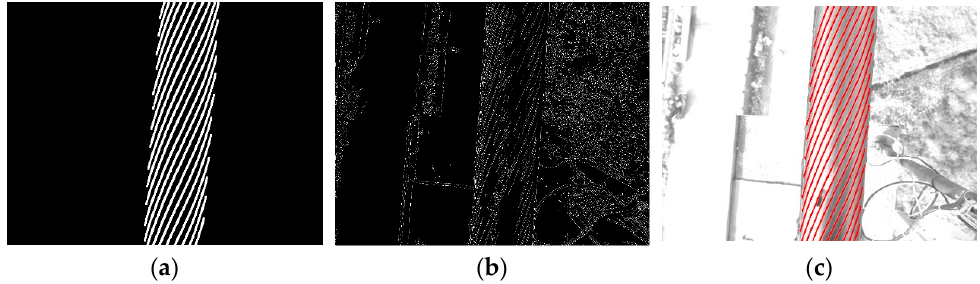
Figure 8. The result of strand segmentation by the proposed method. ( a ) Segmentation template; ( b ) Edge detection result with FoGDbED; ( c ) Strand segmentation by the proposed method.